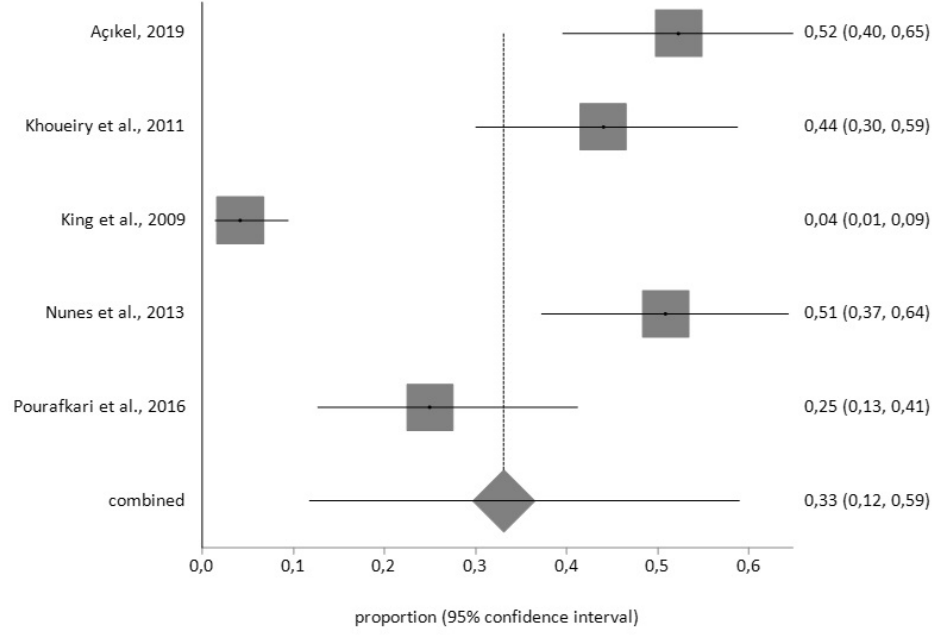
Figure 5. Forest plot for post-CABG depression using BDI.